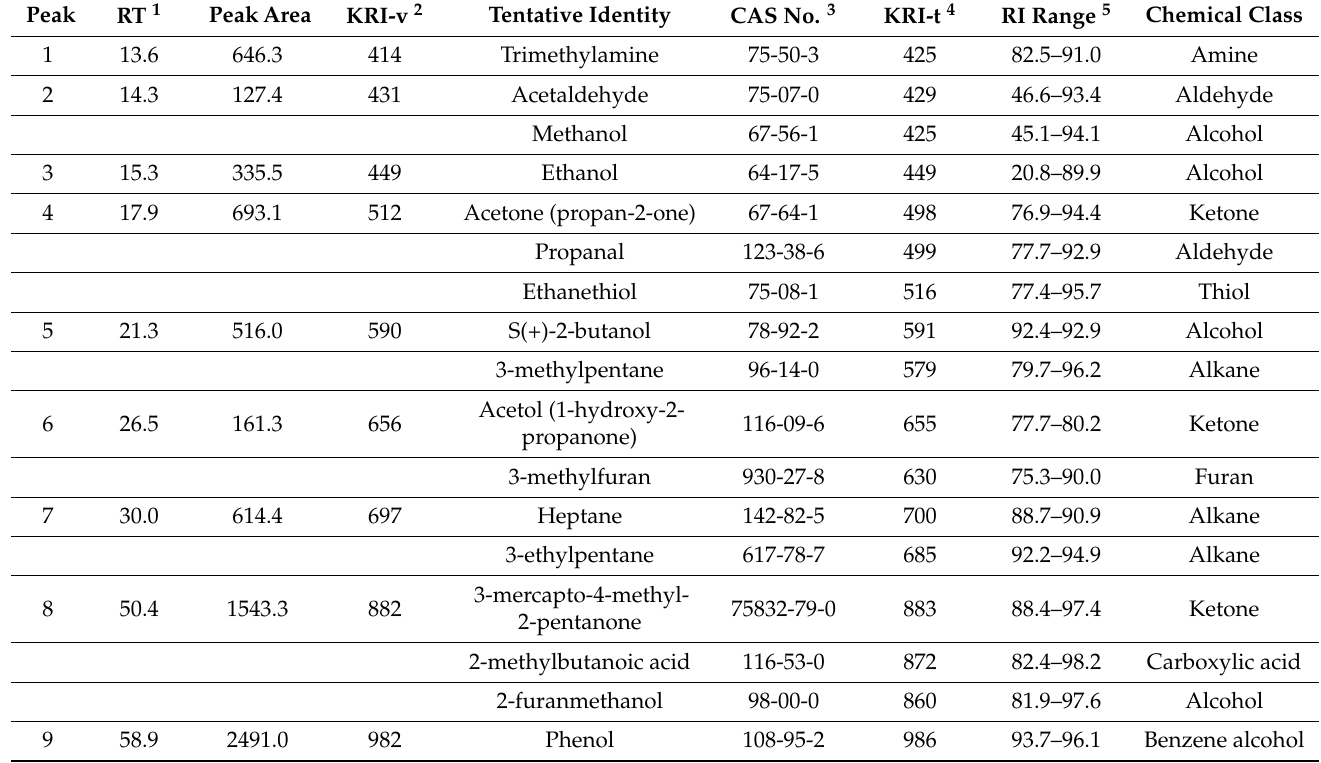
Table 1. Gas chromatographic data indicating tentative identities of whole-body